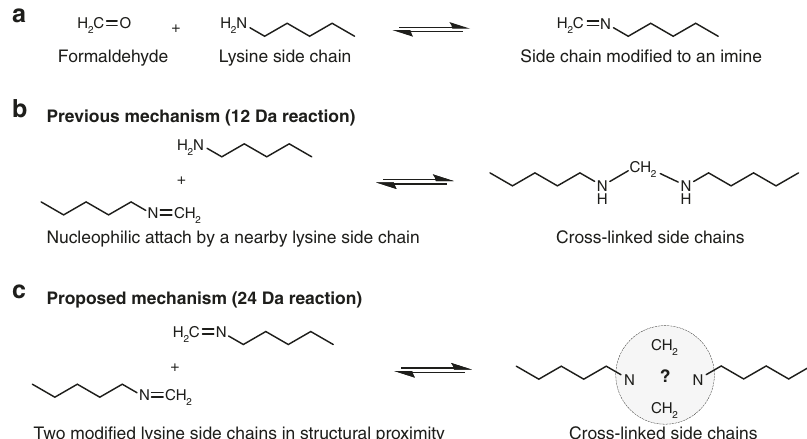
Fig. 5 Proposed mechanism for the 24 Da cross-linking reaction. The mechanism is demonstrated on two lysine side chains. a Formaldehyde modi fi es the primary amine of a lysine side chain into an imine. These modi fi cations are well established by mass spectrometry. b Previously, it was thought that the cross-link is a methylene bridge that forms between a lysine side chain and a nearby imine modi fi cation. c Our data strongly suggest that formaldehyde cross-links are mainly the dimerization product of two modi fi ed side chains. The dimerization step is presumably slow and can occur only in structured proteins, in which the two side chains are close and nearly stationary relative to each other. The current data cannot conclusively determine the chemical structure at the linkage